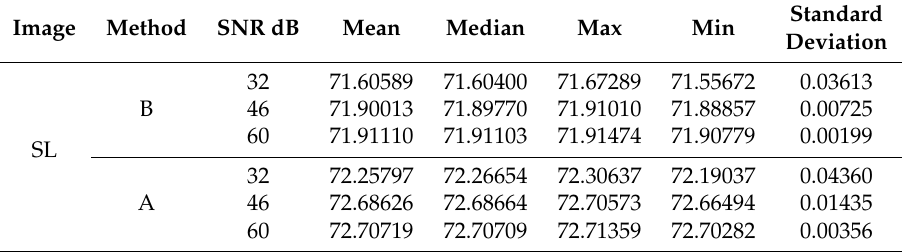
Table 2. Mean, median, maximum, minimum, standard deviation, and number of outliers of box plot element in Figure